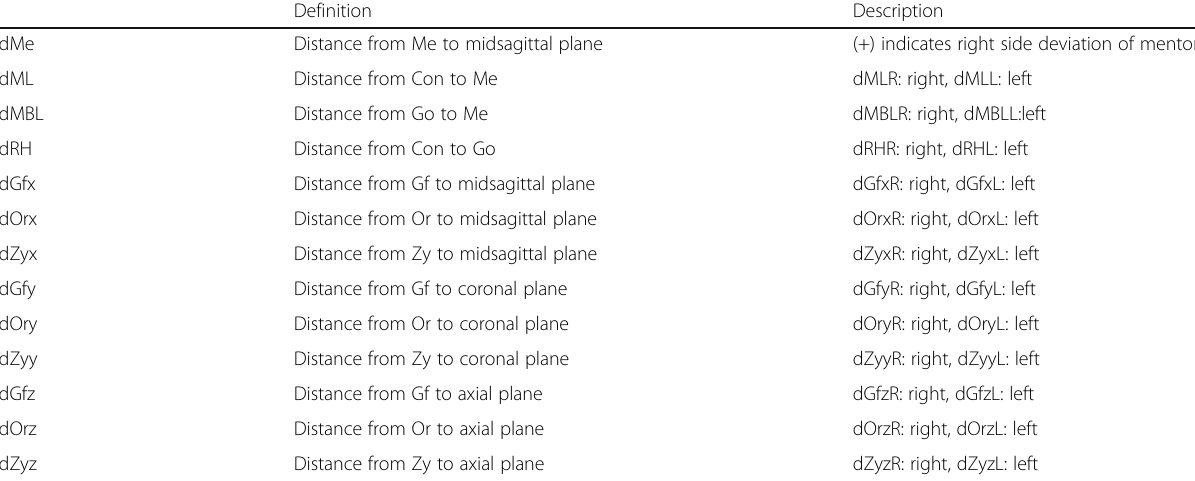
Table 2 Description of craniofacial measurements of distances Definition Description dMe Distance from Me to midsagittal plane (+) indicates right side deviation of menton dML Distance from Con to Me dMLR: right, dMLL: left dMBL Distance from Go to Me dMBLR: right, dMBLL:left dRH Distance from Con to Go dRHR: right, dRHL: left dGfx Distance from Gf to midsagittal plane dGfxR: right, dGfxL: left dOrx Distance from Or to midsagittal plane dOrxR: right, dOrxL: left dZyx Distance from Zy to midsagittal plane dZyxR: right, dZyxL: left dGfy Distance from Gf to coronal plane dGfyR: right, dGfyL: left dOry Distance from Or to coronal plane dOryR: right, dOryL: left dZyy Distance from Zy to coronal plane dZyyR: right, dZyyL: left dGfz Distance from Gf to axial plane dGfzR: right, dGfzL: left dOrz Distance from Or to axial plane dOrzR: right, dOrzL: left dZyz Distance from Zy to axial plane dZyzR: right, dZyzL: left